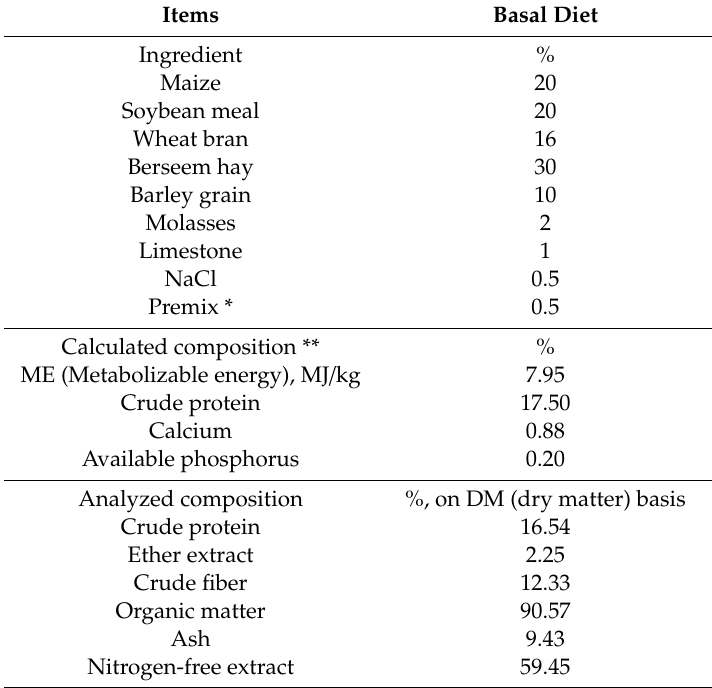
Table 1. Ingredients and composition of the basal diet of growing rabbits (as fed). Items Basal Diet Ingredient %